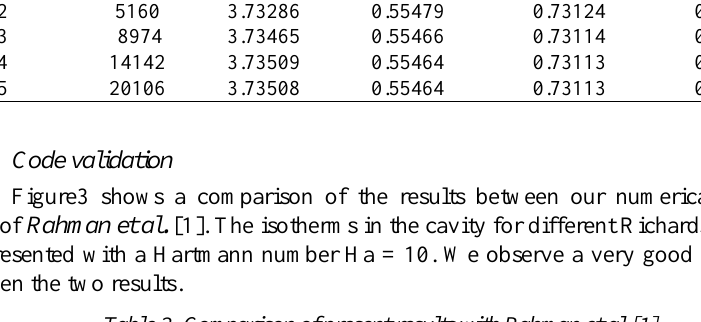
Table 3. Comparison of present results with Rahman et